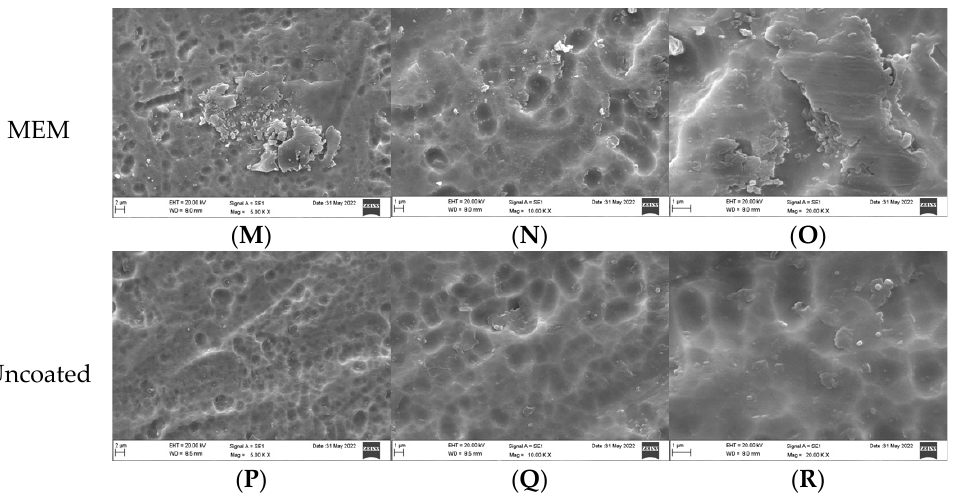
Figure 1. SEM appearance of coated plates without bacteria, including the negative control at 5, 10, and 20k magnification.